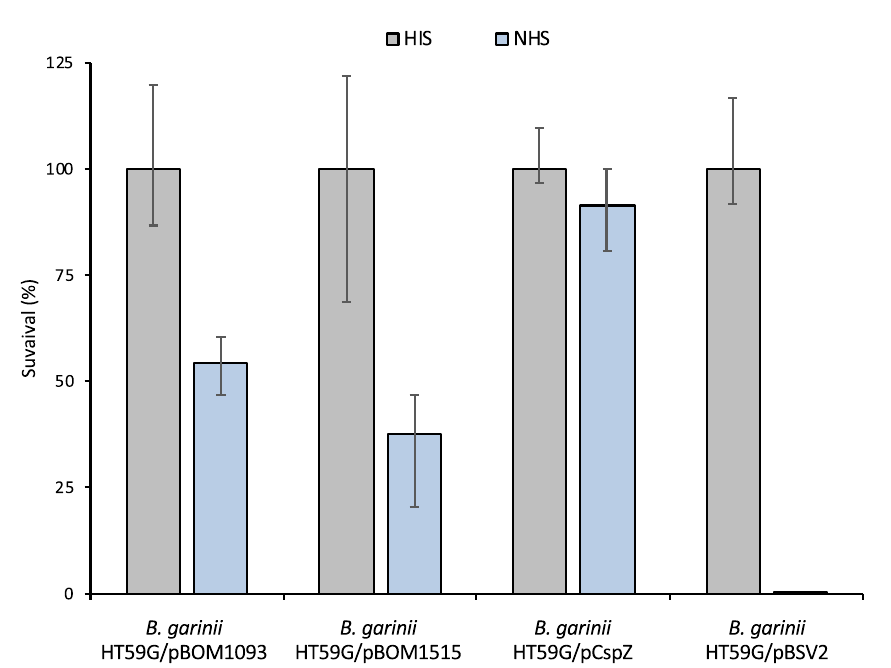
Figure 2. Quantification of serum susceptibility for Borrelia garinii transformants. Each transformant was incubated in either 40% NHS or HIS for 16 h at 34 °C. The colony forming unit (CFU) represents the number of colonies formed. The mock strain ( B. garinii HT59G/pBSV2) and serum-resistant transformant ( B. garinii HT59G/CspZ) were used as controls. The figure depicts the average CFU, and error bars represent the